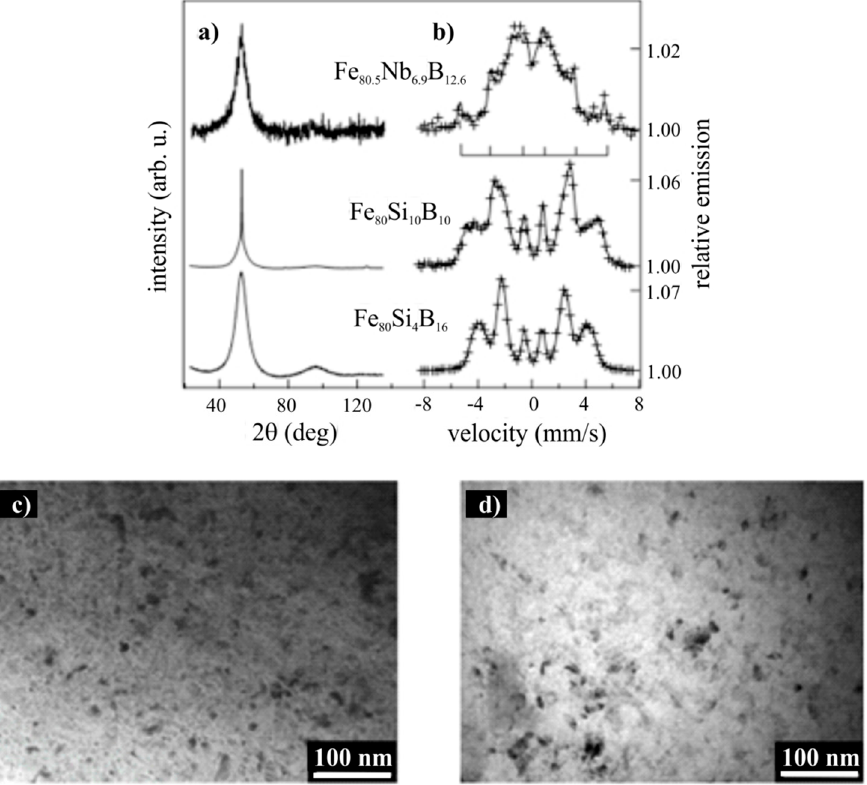
Figure 2. XRD patterns ( a ) and conversion electron Mössbauer spectra ( b ) taken from the air-side of Fe 80 Si 4 B 16 , Fe 80 Si 10 B 10 , and Fe 80.5 Nb 6.9 B 12.6 samples. TEM images of the air-side microstructure for Fe 80 Si 10 B 10 ( c ) and Fe 80.5 Nb 6.9 B 12.6 ( d ) samples.